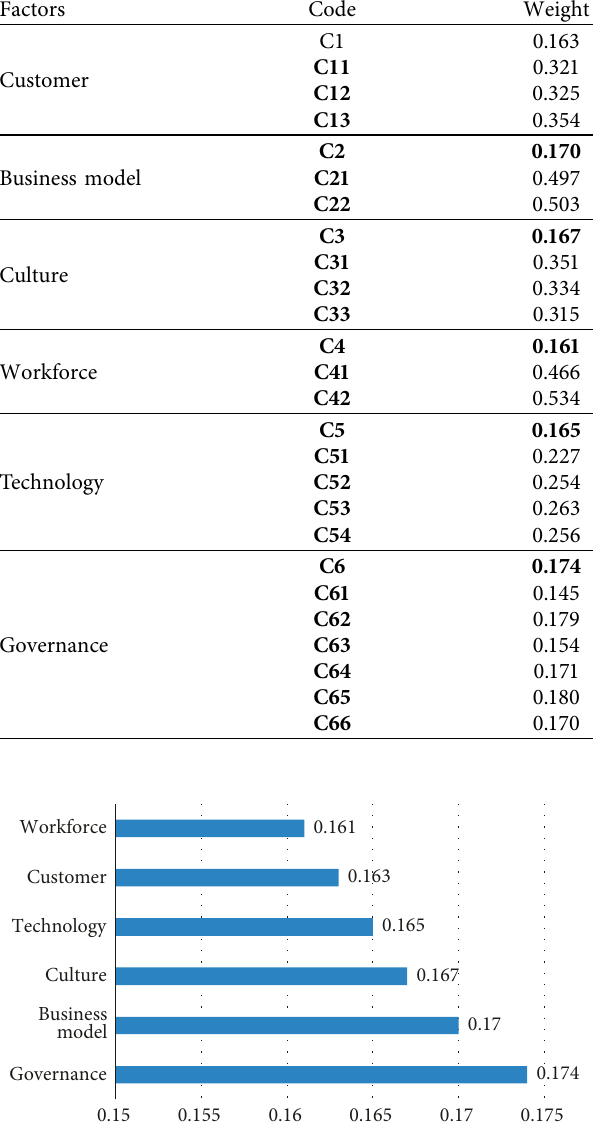
Table 8: Global factors weight.